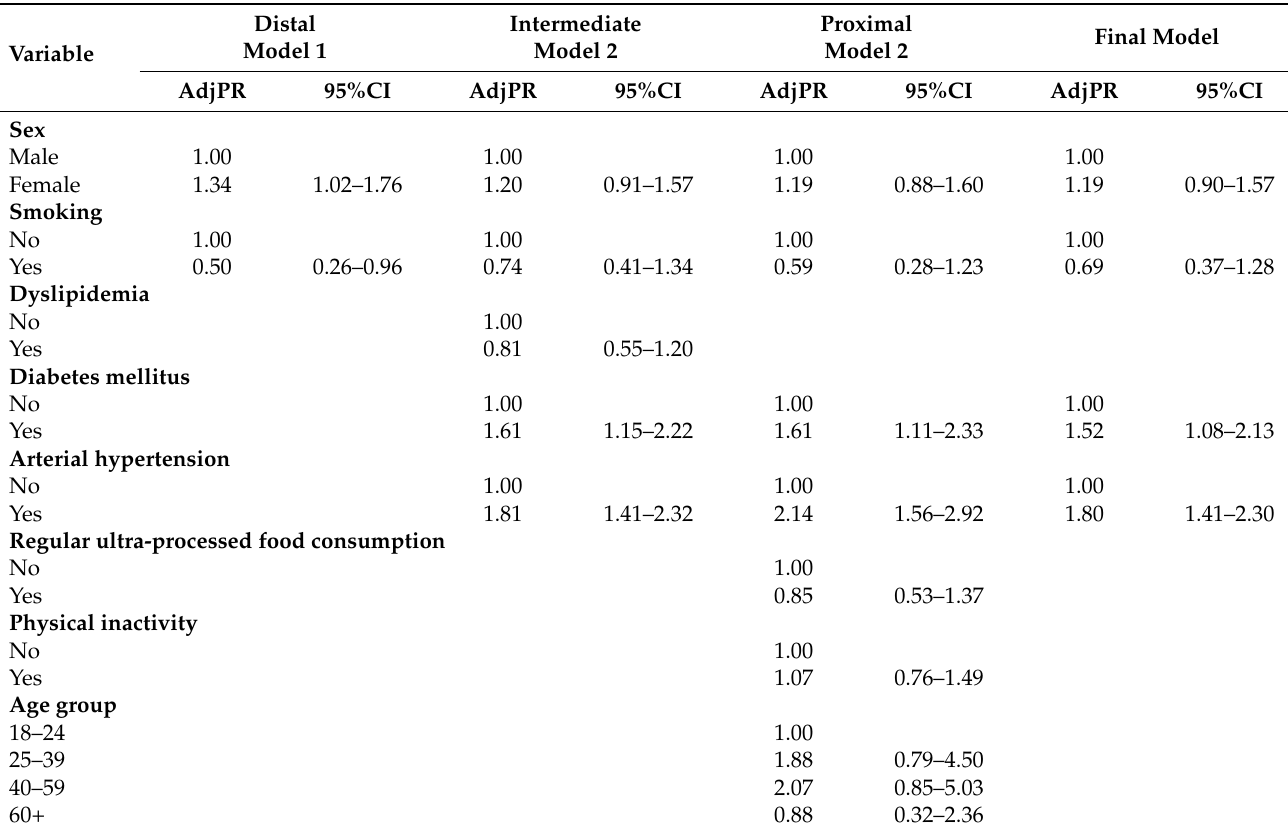
Table 4. Factors associated with obesity in adults from Rio Branco, Acre,